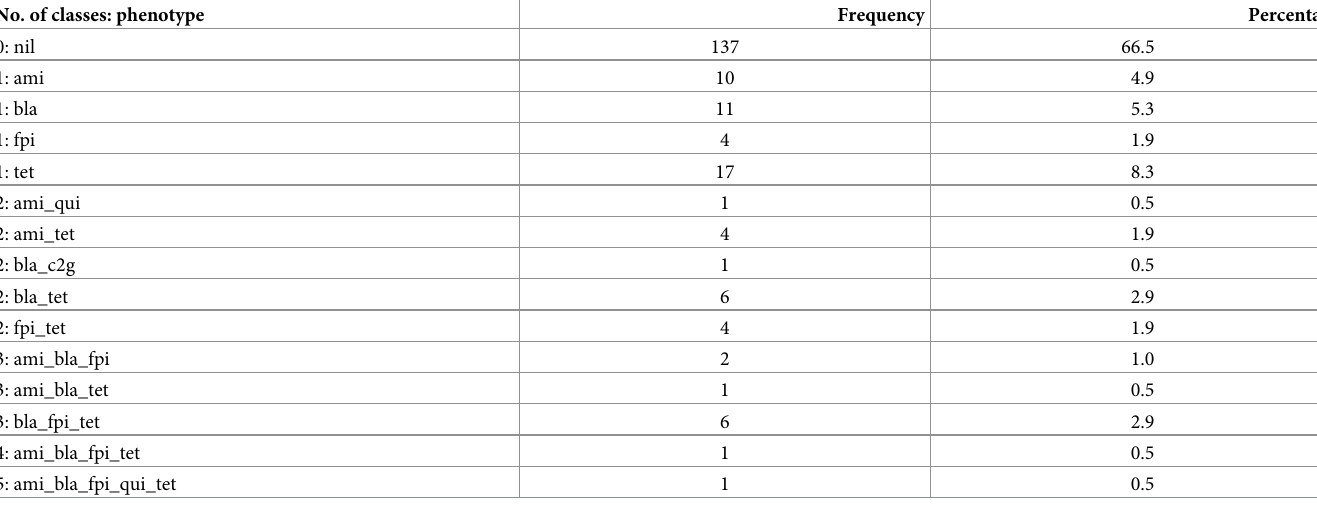
respectively. Both of these carried a single point mutation in the QRDR of gyrA , with the ST752 and ST4980 isolates each displaying amino acid mutations of Glu-475-Asp, and Ser- 83-Leu and Asp-87-Gly, respectively (Table 5). All Salmonella isolates (Sofia) that had elevated MICs for cefoxitin (n = 6; 16 mg/L) were subjected to whole genome sequence analysis. Sequencing revealed all of these Salmonella iso- lates belonged to sequence type ST2116 ( Salmonella Sofia), with no known antimicrobial resis- tance genes detected for any antimicrobials. Table 3. Antimicrobial resistance profiles of Escherichia coli isolates from Australian poultry based on ECOFFs (n = 206). No. of classes: